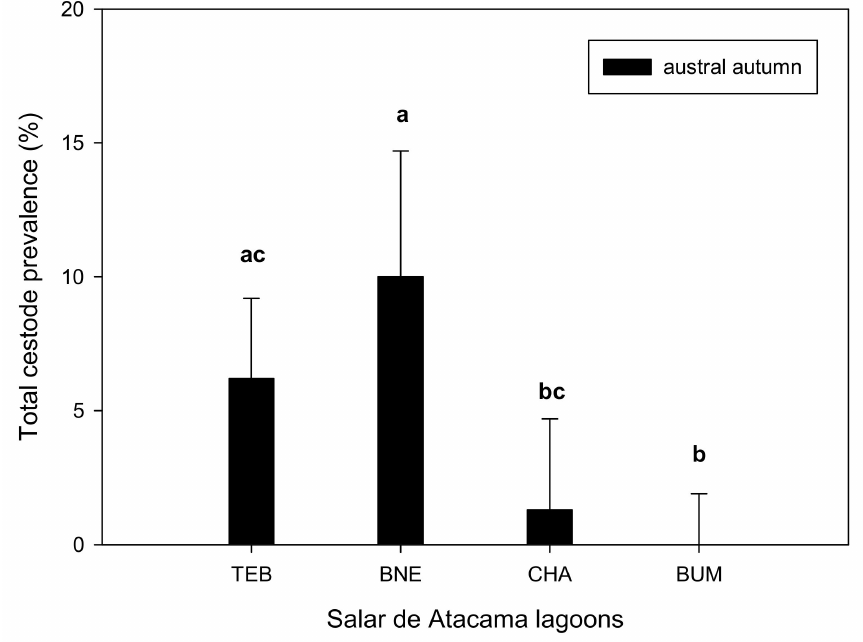
Figure 3. Prevalence of cestode infection in A. franciscana from several localities in Salar de Atacama (north of Chile) in austral autumn. Bars show upper 95% confidence intervals. TEB, Tebenquiche; BNE, Barros Negros; CHA, Chaxas; BUM, Burro Muerto. Different lower letters indicate statistical differences among sites after Post Hoc procedures with Bonferroni